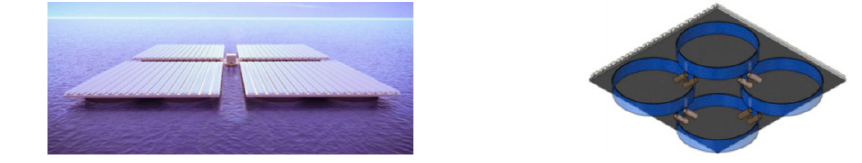
Figure 6. HelioFloat Offshore Platform [34]. [Permission of using the figure has been requested from the copyright holder Dr. Roland Eisl].